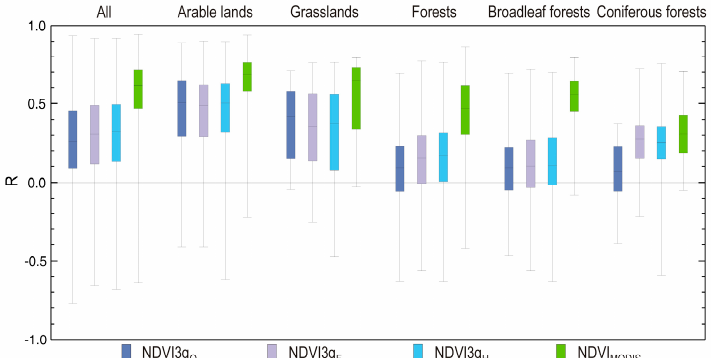
Figure 9. Box-whisker plots of the correlation coefficients between the precipitation anomaly in August and the NDVI anomaly in September derived from the NDVI3g O (dark blue, the first column in every LC group), NDVI3g F (purple, the second column in every LC group), NDVI3g H (light blue, the third column in every LC group) and NDVI MODIS (green, the fourth column in every group) datasets for all vegetated pixels of the study area, and for different land cover types. (Box-whisker plots are indicating maximum, upper quartile, median, lower quartile, and minimum values.)